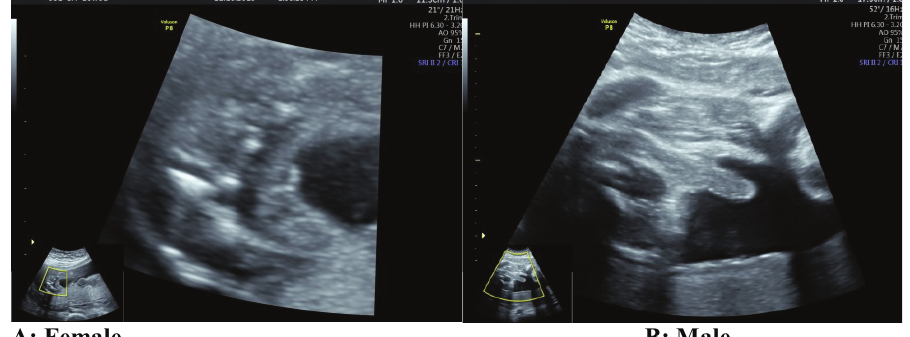
Figure 2 : Ultrasound scan appearance of fetal sex in second trimester.